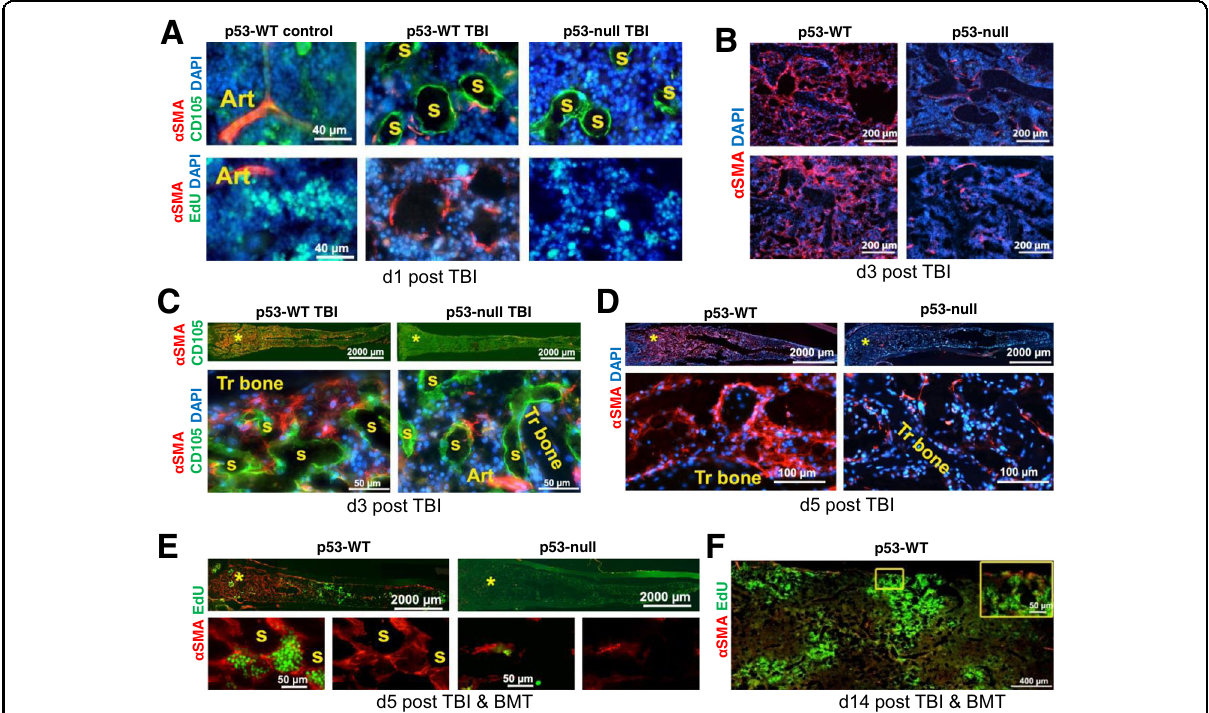
Fig. 3 IR induces appearance of α SMA-positive fi broblast-like cells in the BM of p53-WT mice but not in the BM of p53-null mice. A Longitudinal sections of femoral BM (distal metaphysis area) from a control (non-irradiated) p53-WT mouse and irradiated (13 Gy) p53-WT and p53- null mice stained for α SMA, CD105, and DAPI (upper panel) or for α SMA, EdU, and DAPI (low panel). Analysis was performed 24 h post IR. EdU was injected intraperitoneally 1h before mouse sacri fi ce. B Massive appearance of α SMA cells in the BM of p53-WT mice was a result of irradiation and was not related to BMT. p53-WT and p53-null mice were irradiated with 6 Gy or 15 Gy of TBI (no BMT) and α SMA + cells were detected in sections of femoral BM by immuno fl uorescence 3 days after irradiation. C Longitudinal sections of femoral BM from irradiated (13 Gy) p53-WT and p53-null mice prepared 3 days post IR. Upper panels: low magni fi cation (×2.5) of whole femurs stained for α SMA and CD105. Lower panels: high magni fi cation (×40) of boxed areas stained for α SMA, CD105, and DAPI. D Longitudinal sections of femoral BM from irradiated (13 Gy) p53-WT and p53-null mice prepared 5 days post IR and stained for α SMA and DAPI. Upper panels: low magni fi cation (×2.5) of whole femurs; Lower panels: high magni fi cation (×40) of boxed areas. E Longitudinal sections of femoral BM from IR p53-WT and p53-null mice after BMT (5 days after IR with 13 Gy) stained for α SMA and EdU. Upper panels: low magni fi cation (×2.5) of whole femurs; lower panels: high magni fi cation (×40) of boxed areas. F Longitudinal sections of femoral BM (distal metaphysis) from p53-WT mouse after BMT (14 days after BMT) were stained for α SMA and EdU. EdU was injected intraperitoneally 1h before mouse sacri fi ce. The inset panel shows the boxed area at high magni fi cation (×40). For A – F : S sinusoid, Art arterial vessels, Tr. Bone trabecular bone. Stars in diagrams and in low imaging of femur show areas of fl uorescent pictures. Representative images are shown from the analysis of 3 – 5 mice for each